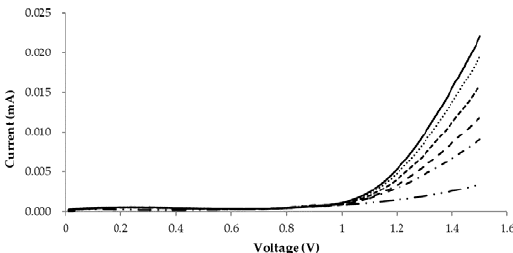
Figure 3. Plot of the current generation against applied potential measured by linear sweep